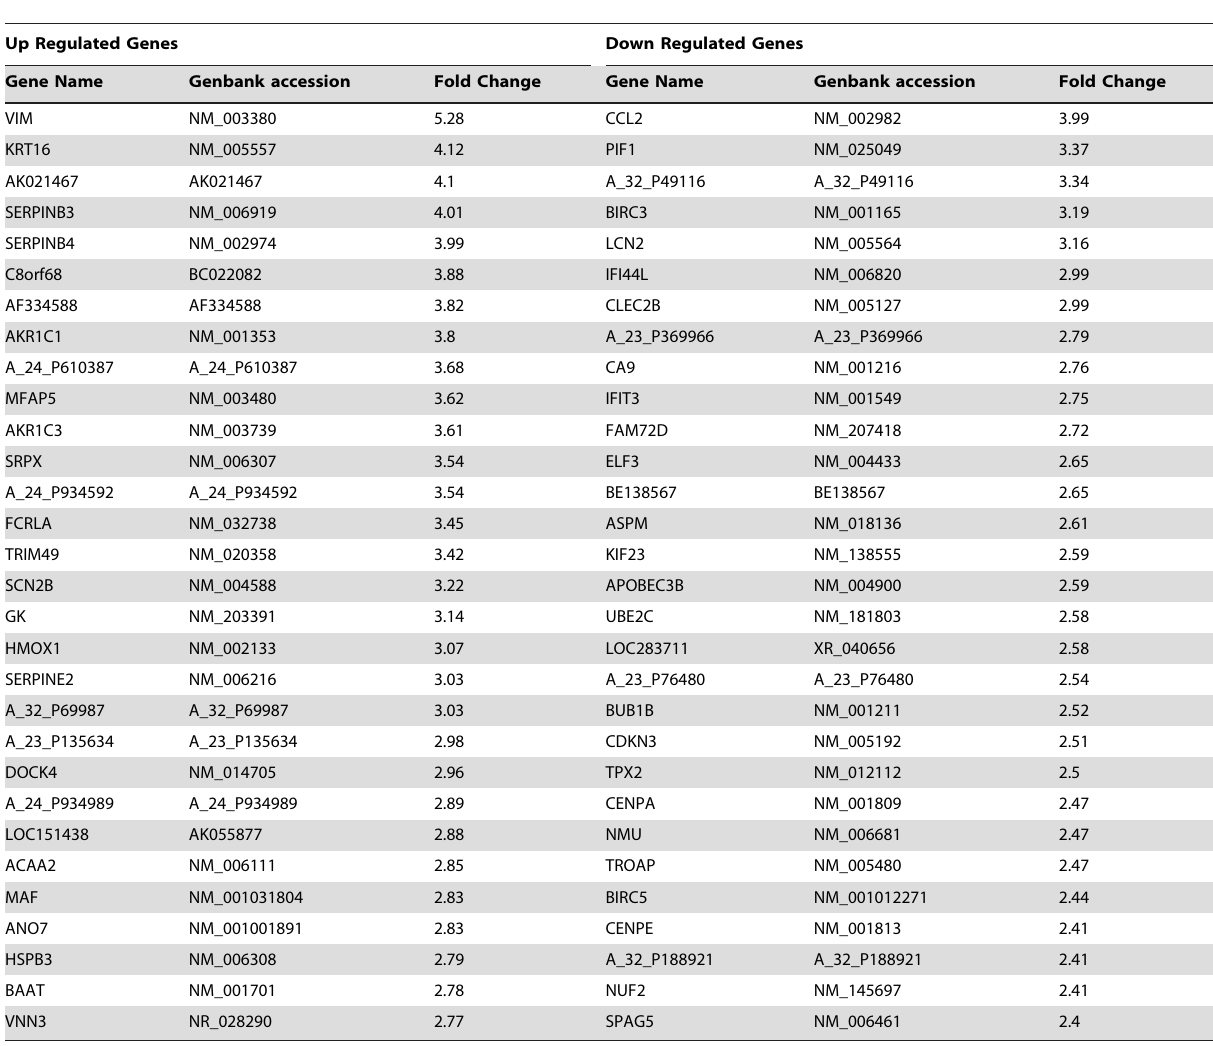
Table 3. List of top 30 genes showing Up or Down regulation upon areca nut treatment on HaCaT cells.